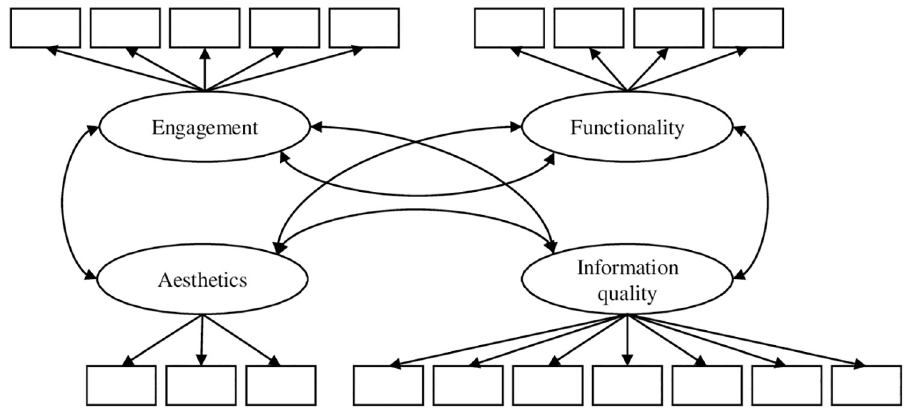
Fig 1. Hypothesized CFA model 1 of the MARS. Item-wise error variances are not represented in the models; correlations between errors were not allowed.